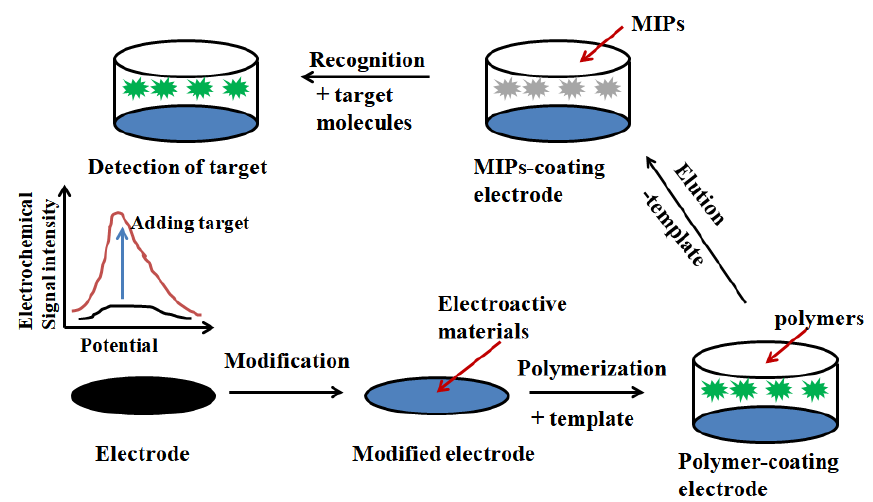
Figure 9. Schematic illustration of the fabrication and application of MIPs-based electrochemical biosensors. Adapted from ref [10]. biosensors. Adapted from ref